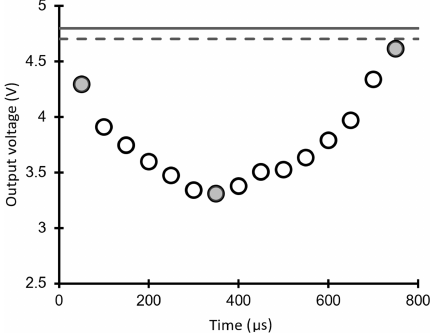
Figure A1. An example of temporal variation of output voltage due to a drop that passed through the laser beam. The solid line denotes the base voltage, the dashed line denotes the threshold voltage, the open circle denotes the output voltage every 50µs and the closed circle denotes the data recording onto the